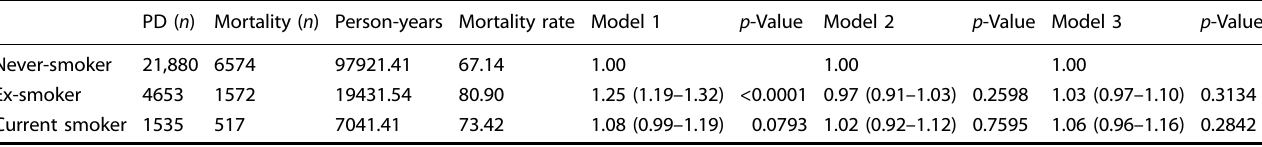
Table 2. Cox proportional hazard regression analysis on the risk of all-cause mortality in patients with Parkinson ’ s disease according to smoking